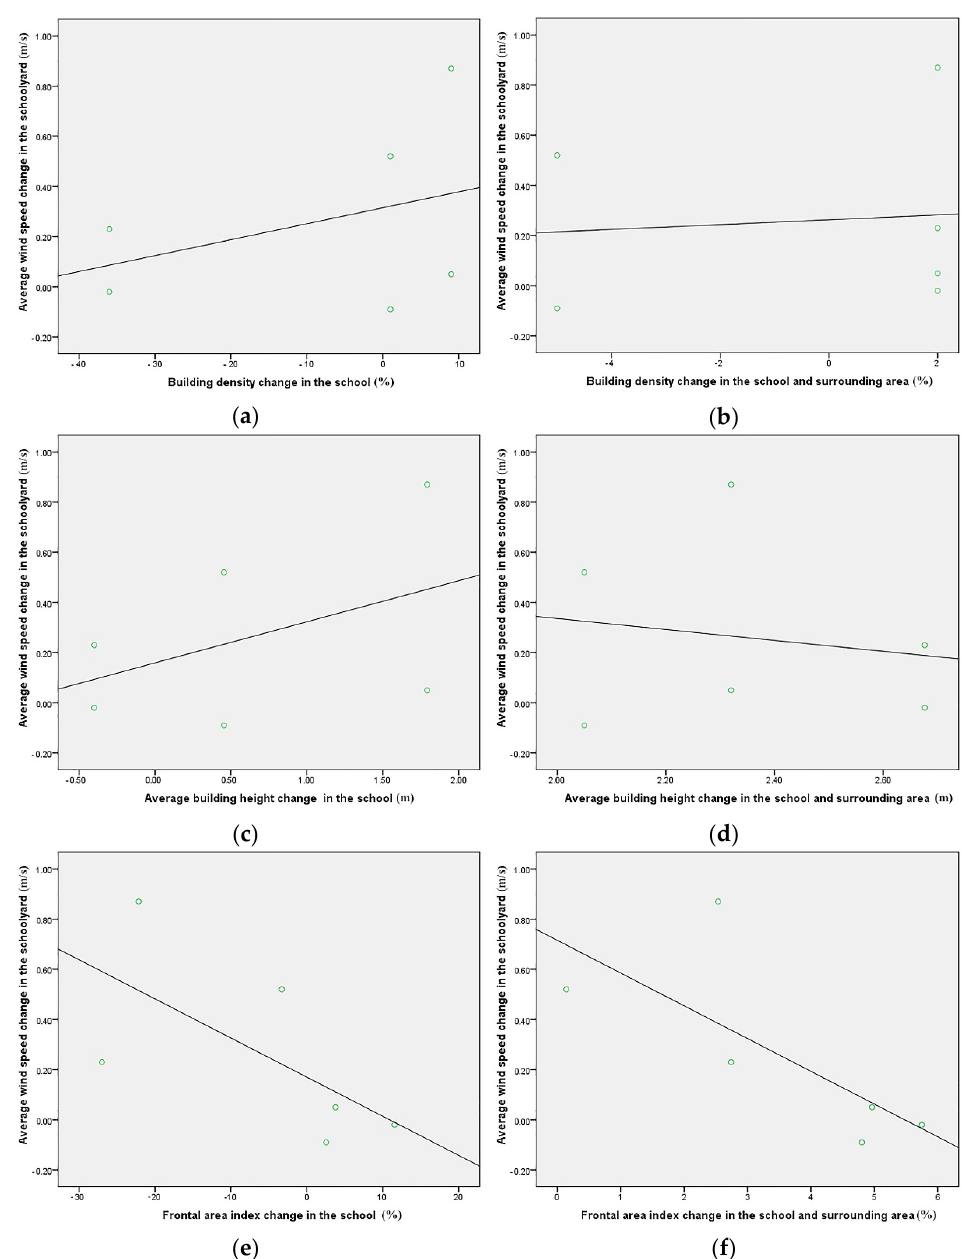
Figure 13. Relationship between the change of morphological parameters and mean pedestrian- level wind speed: ( a – f